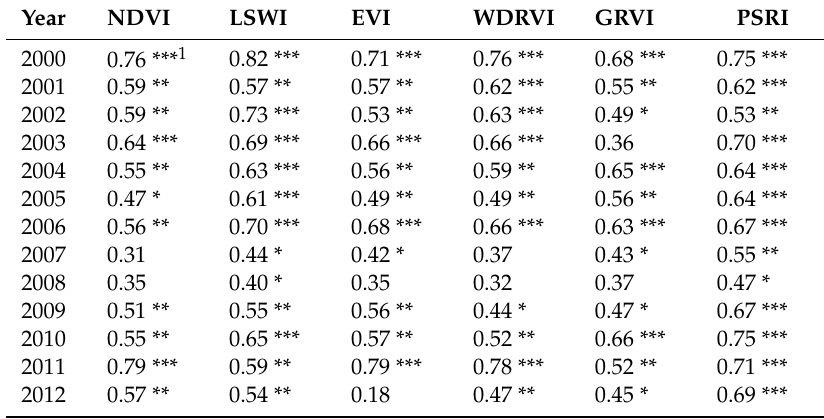
Table 2. Correlation coe ffi cients in spatial series between growing season end dates retrieved from di ff erent VIs and ground-observed leaf fall end dates in each year.